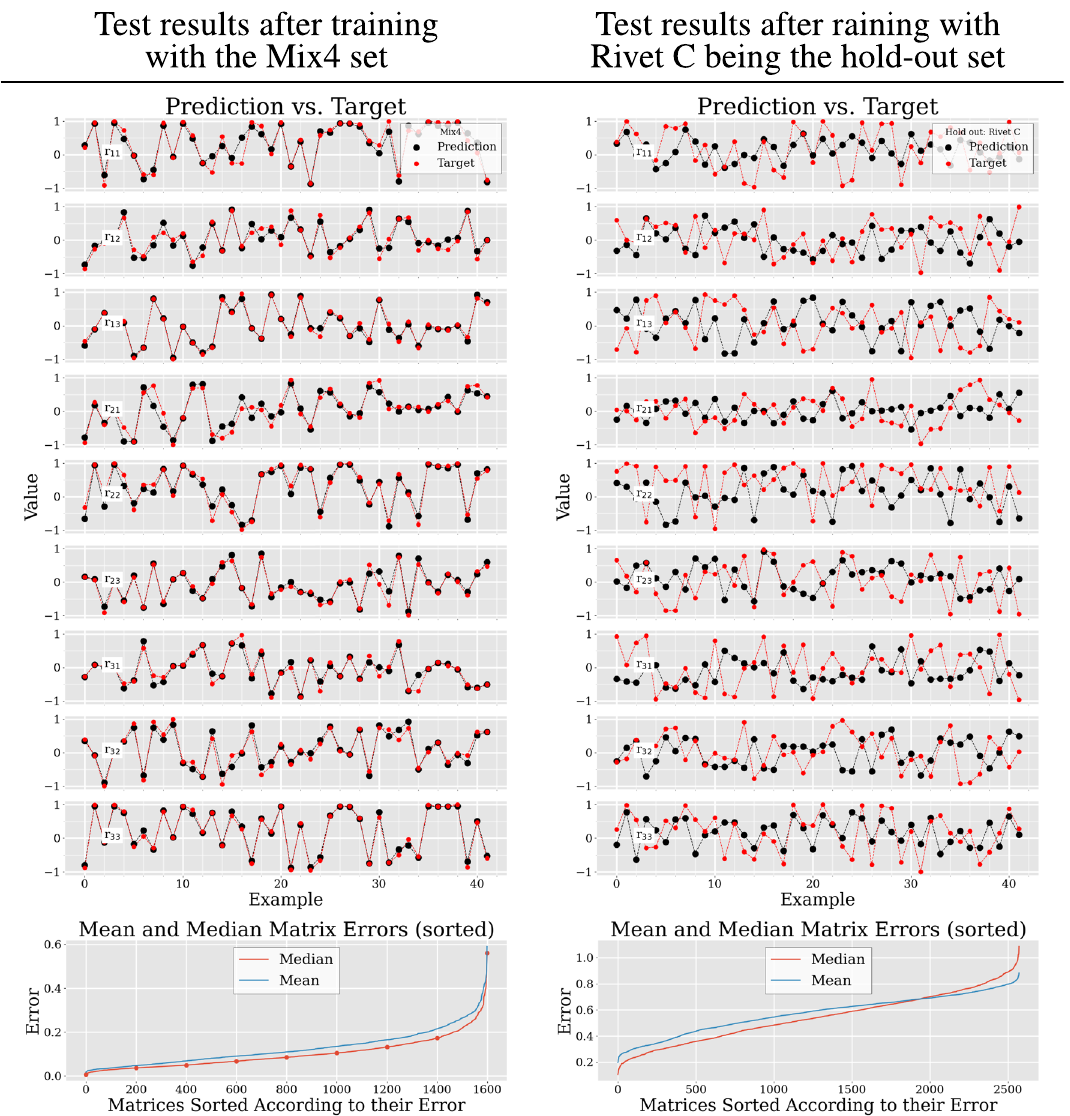
get clearer. Bottom graph: Matrix mean and median errors in sorted order. Here, all matrices are sorted according to their mean and median errors in ascending order. This shows, that in the case of the Mix4 data set the majority (approximately 80%) of the matrix errors stay below 0.2. However, when Rivet C was the hold out set, almost every predicted matrix produced errors larger than 0.2. The red dots in the graph on the bottom left mark the examples that are shown in Fig.